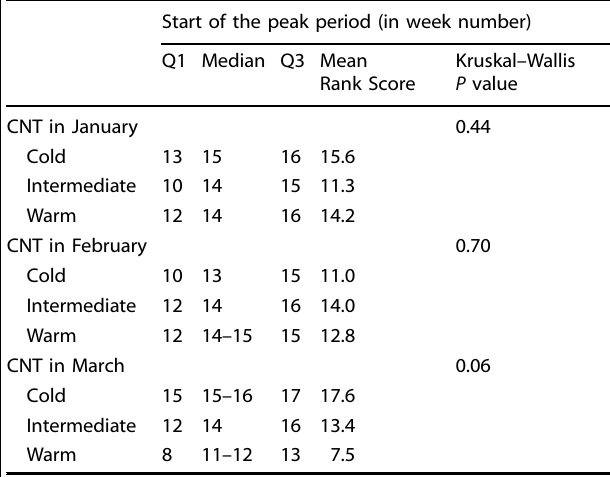
Table 2. Differences in timing of the start of the SAR peak period between relatively cold or warm start of the